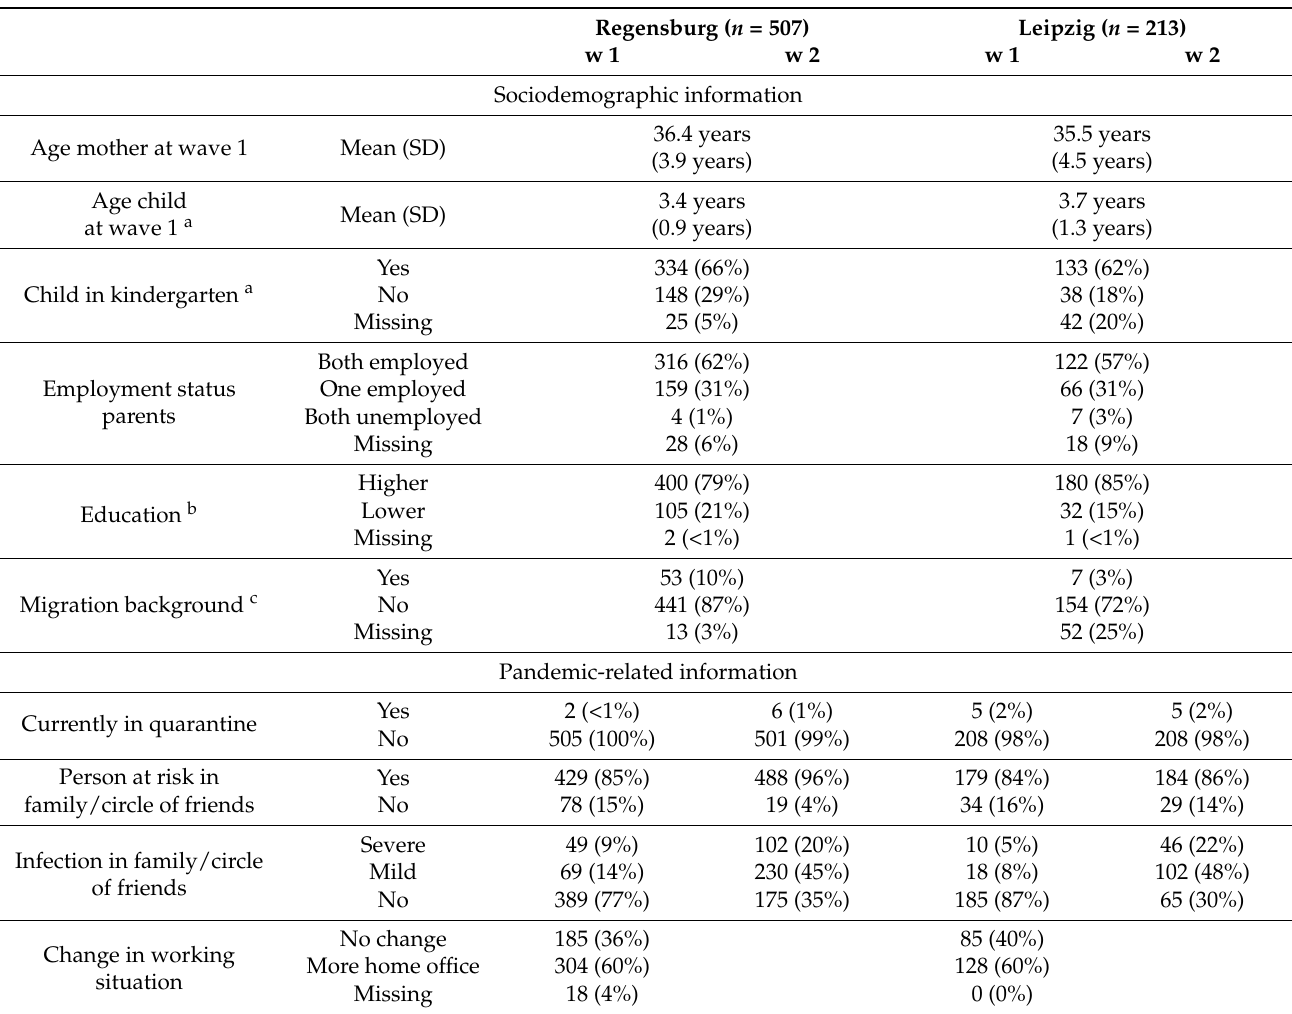
Table 1. Characteristics of the study populations in Regensburg and Leipzig at wave 1 and wave 2 of the COVID-19